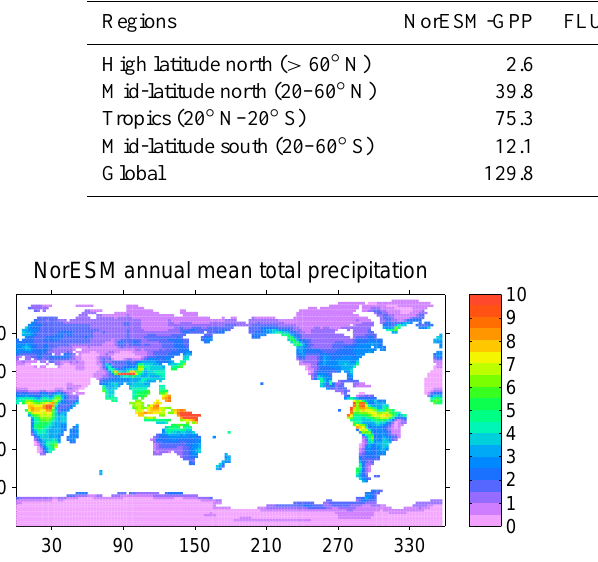
Fig. 17. Maps of daily mean total (liquid and ice) precipitation over land for years 1982–2005 as simulated by the NorESM. Units are in (mmday − 1 ).